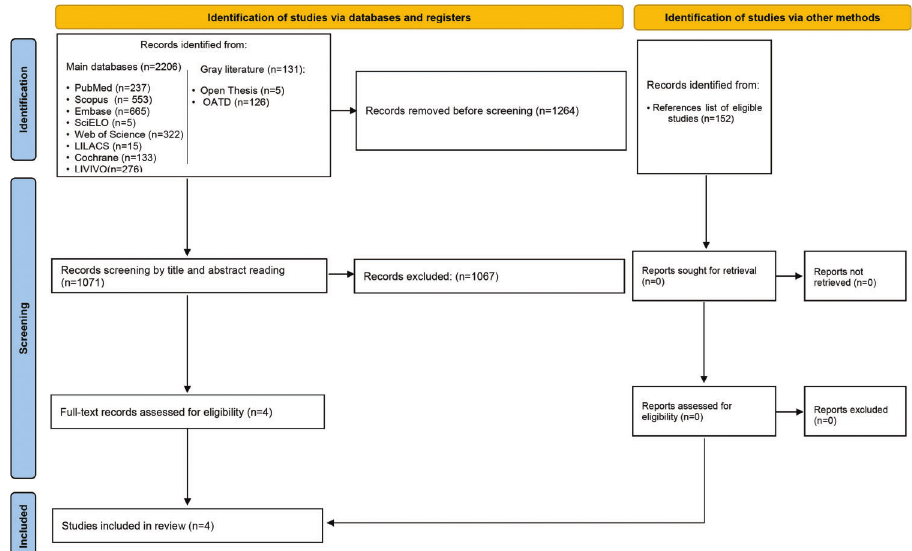
Figure 1 - Flow chart of the study selection